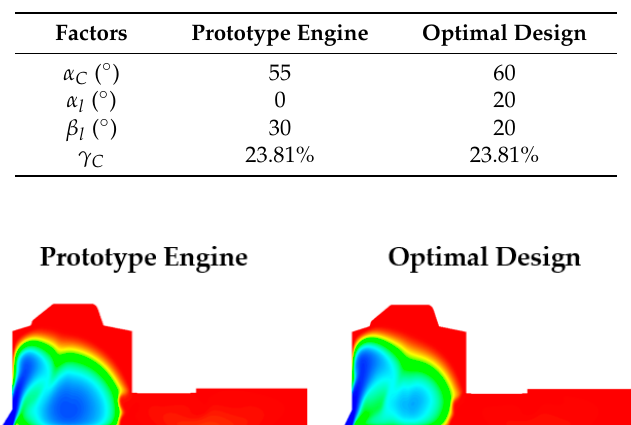
Table 10. Investigated factor values before and after optimization.